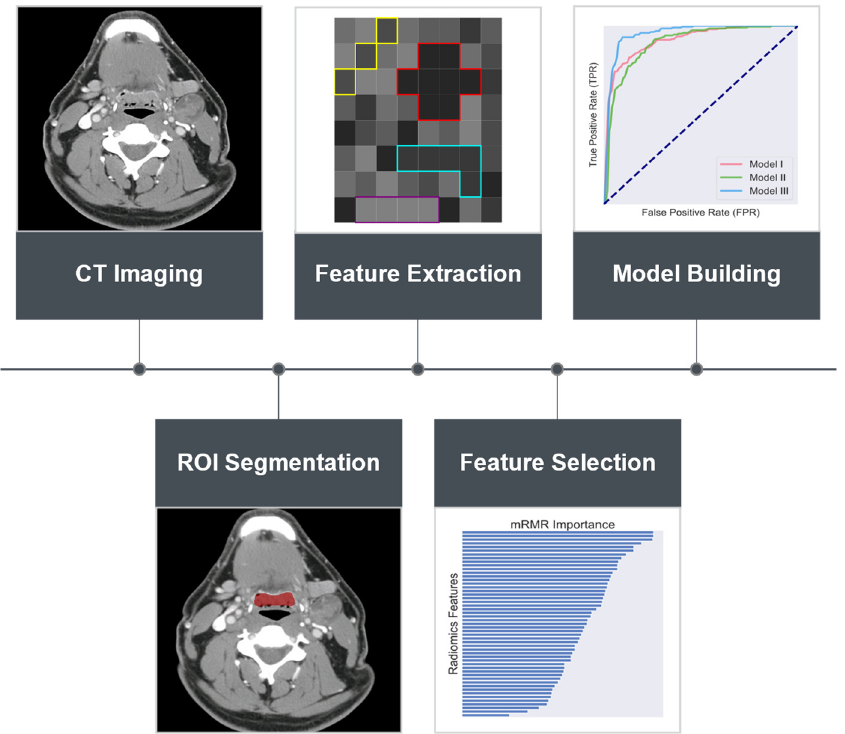
Figure 1. Workflow of the key steps in radiomics analysis using simulation CT for the differentiation of distant metastasis status in locally advanced human papillomavirus-positive (HPV+) oropharyn- geal squamous cell carcinoma (OPSCC). Primary gross tumor volumes (GTVs) were delineated on the simulation CT for each of the studied patients. Radiomics features were then extracted from the identified primary GTV volumes. Feature selection was conducted employing minimum redundancy maximum relevance (mRMR) that prioritizes radiomics features with high relevance to the target class while low redundancy to each other, followed by building support vector machine (SVM)-based classifiers using the selected features.